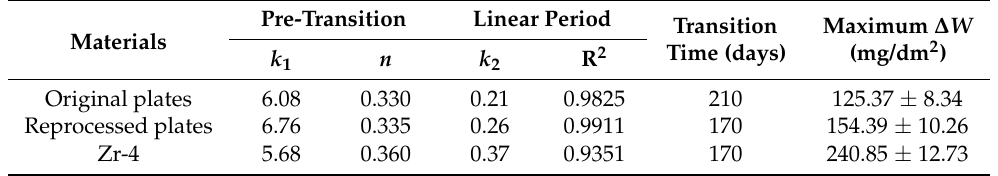
Table 3. Fitting results for pre-transition and